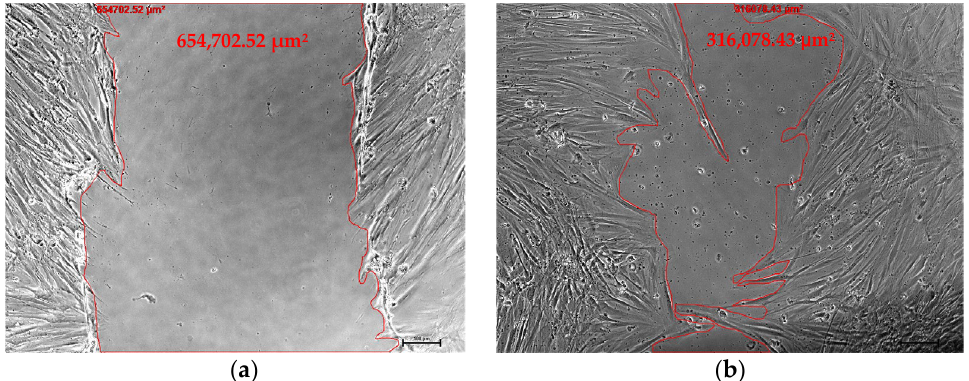
Figure 8. The wound area was demonstrated by the cell-free area within the scratch. The phase contrast micrographs of CTRL were taken on ( a ) day 0 and ( b ) day 2. Each photo was calibrated with 100× magnification. The surface area of the wound was measured in units of µm 2 using Axiovision software.